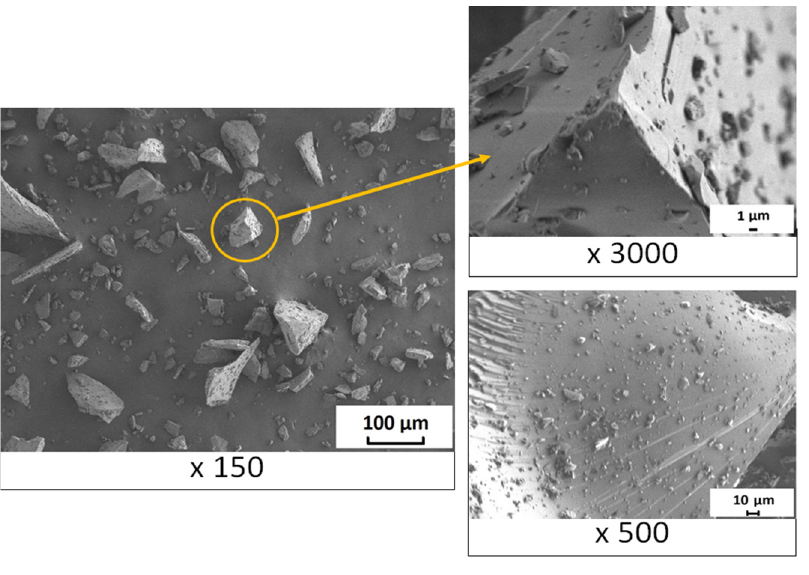
Figure 3. Micrographs of BP particles.